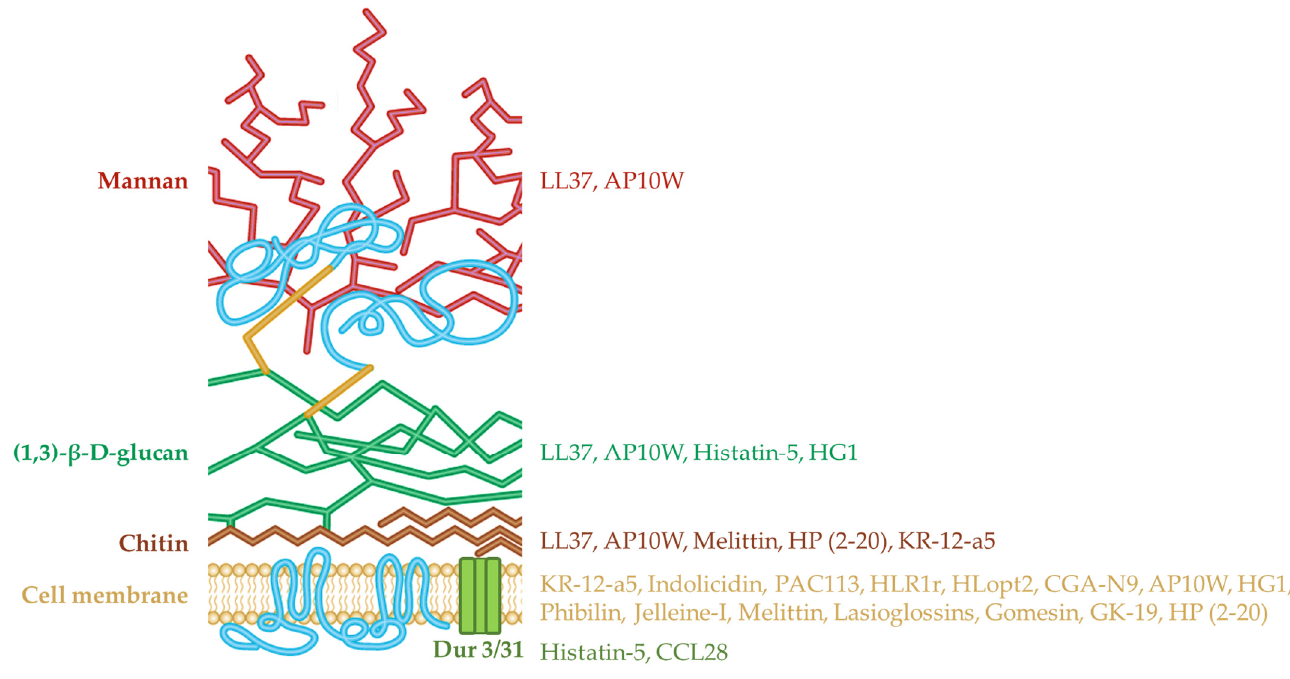
Figure 1. Schematic representation of cell membrane and cell wall targets of antimicrobial peptides with anti ‐ Candida activity.